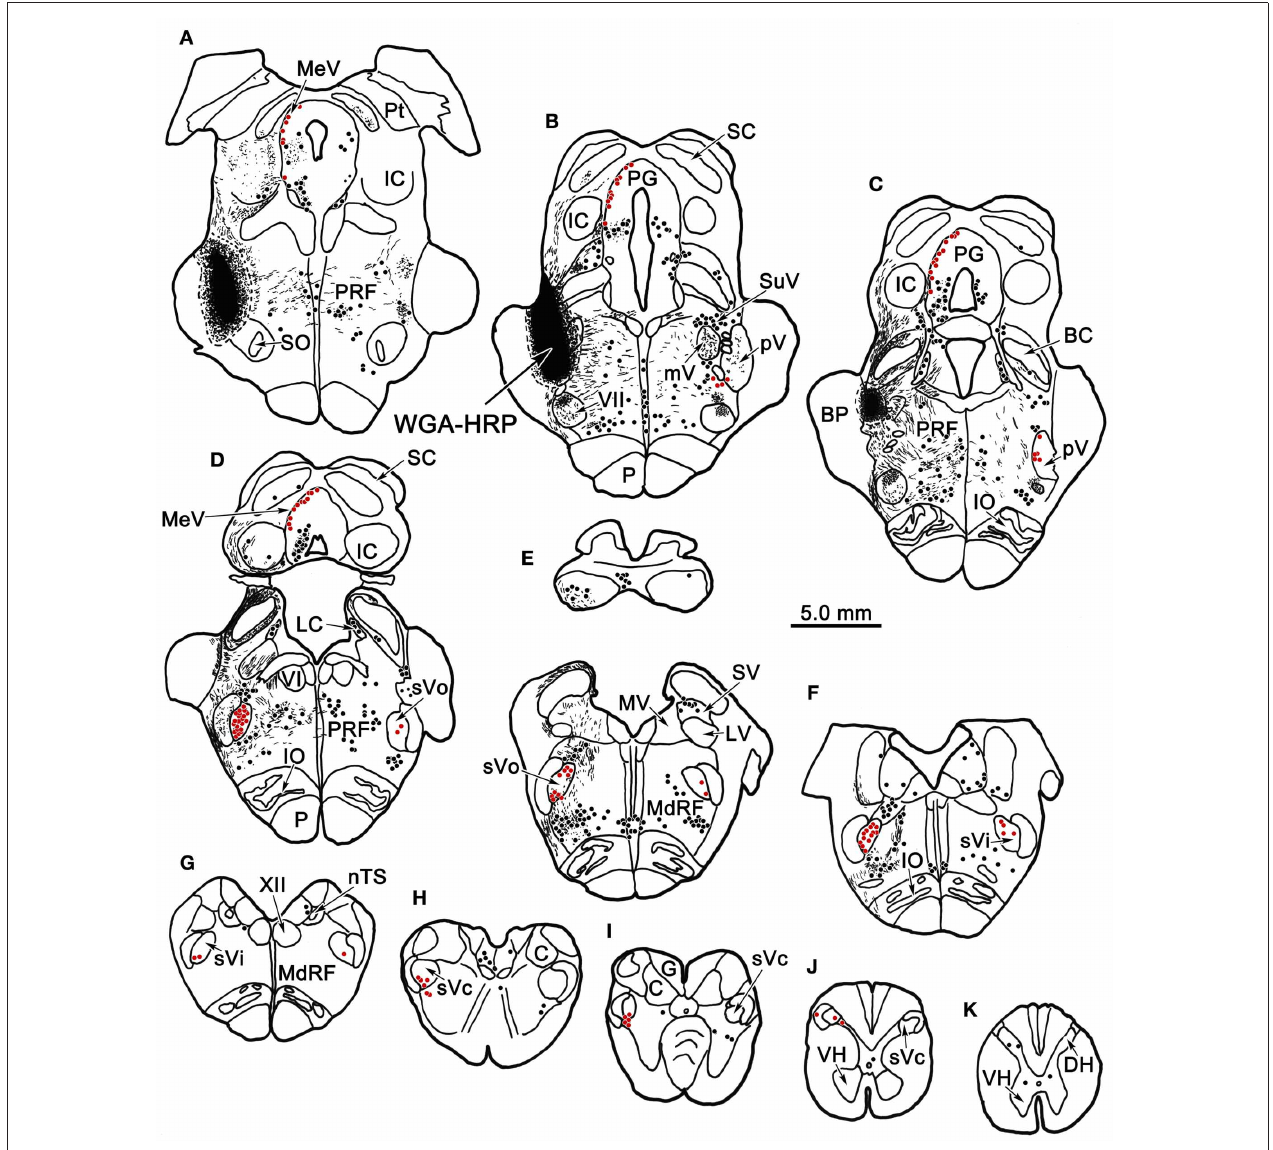
FIGURE 1 | Charting of the distribution of anterogradelylabeledaxons (lines) and terminals(stipple), and retrogradely labeledneurons (dots) followinga wheatgermagglutininconjugatedhorseradish peroxidase (WGA-HRP) injection centered in the principaltrigeminalnucleus. Labeled intratrigeminal neurons(red dots)and terminals are distributed throughoutthe spinaltrigeminalcomplex.Otherretrogradelylabeledneurons(blackdots)were concentratedin the reticular formationand periaqueductalgray, and were also presentin vestibular nucleiand spinal cord. Abbreviationsfor figures:BC, brachium conjunctivum;BP, brachium pontis;C, cuneatenucleus;Cf, cuneate fasciculus; DH, dorsalhorn;DV,descendingvestibular nucleus;eC, external cuneatenucleus;G,gracilenucleus;Gf,gracilefasciculus;IC,inferiorcolliculus;